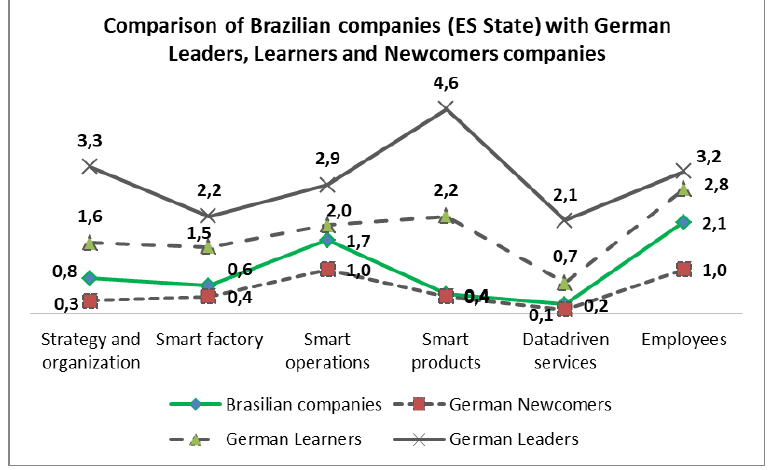
Figure 7. Comparison of overall result of Brazilian companies (ES State) with German companies classified as Newcomers (0 to 1), Learners (2) and Leaders (3 to 5).